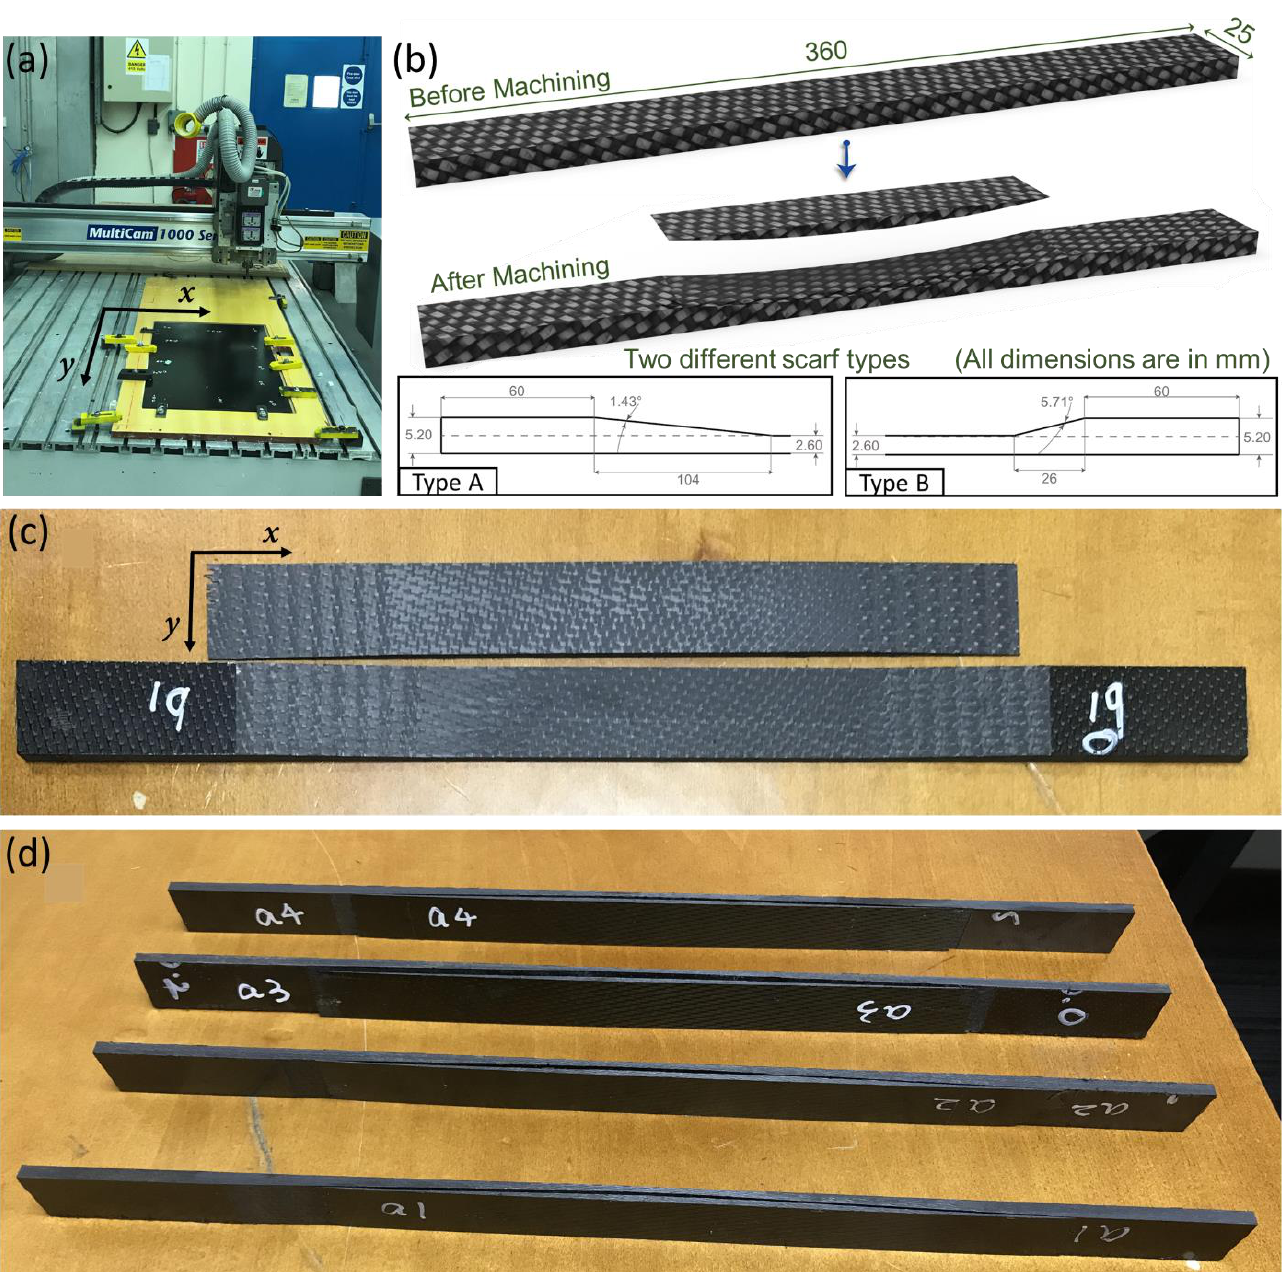
Figure 1. ( a ) CNC router used for the machining of the scarf joints and ( b ) the dimensions of two different scarf geometries. ( c ) A sample specimen with machined surfaces, ( d ) a set of machined samples ready for